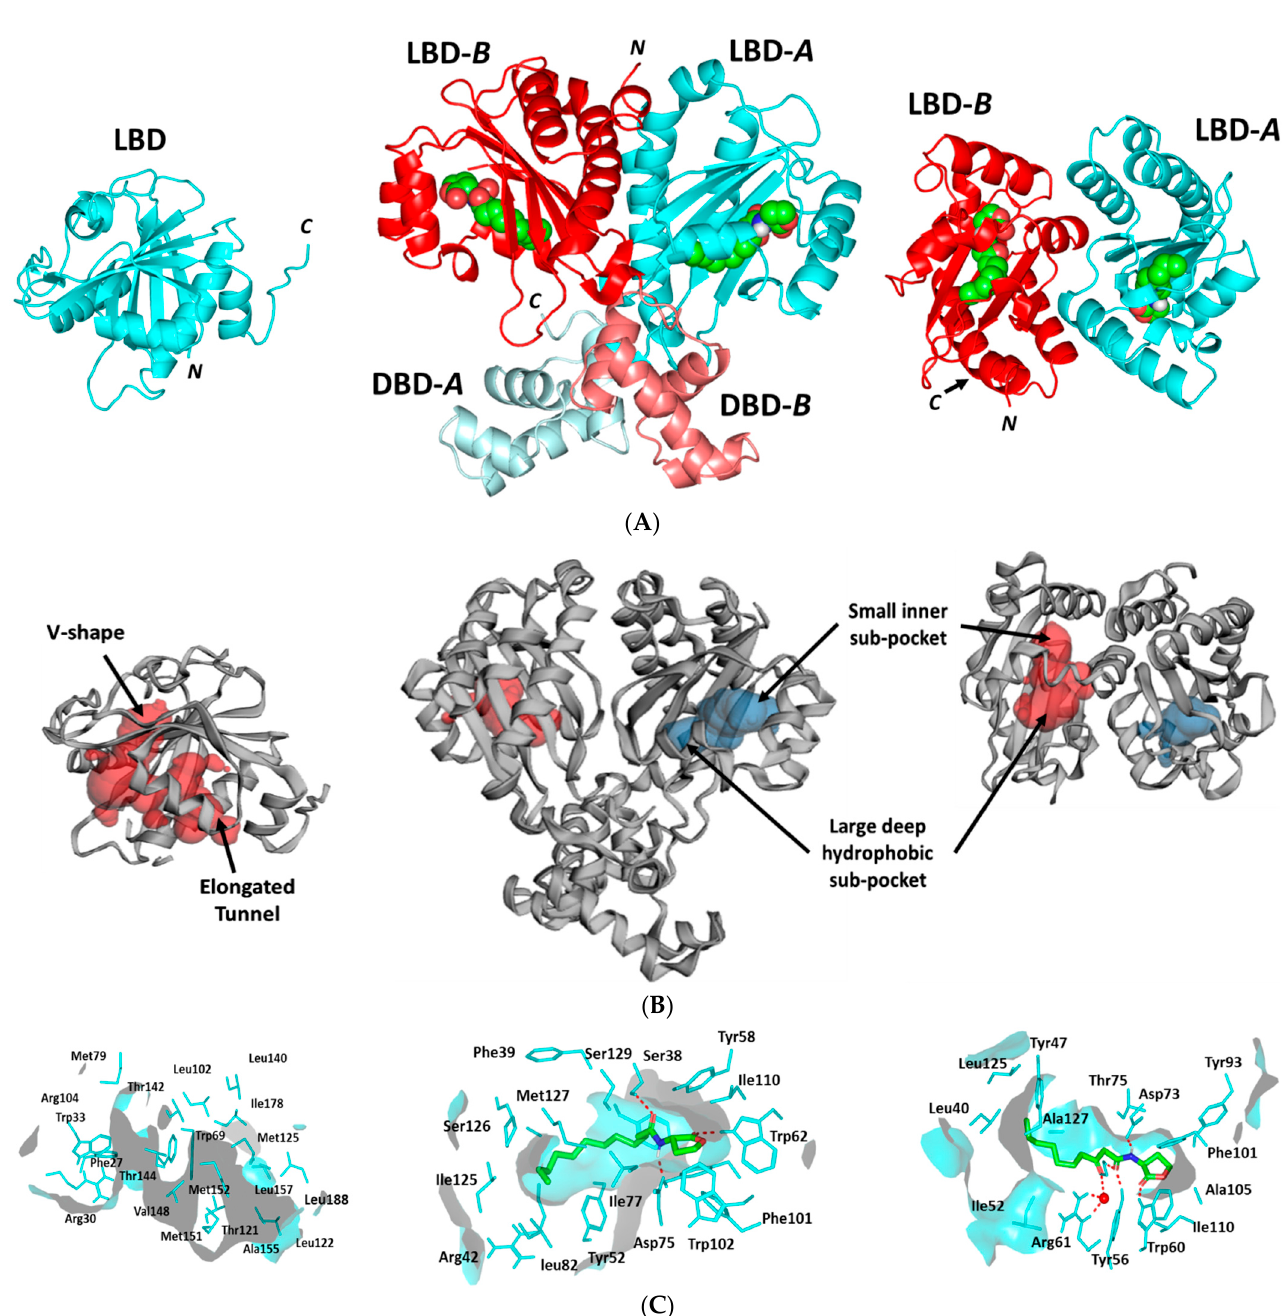
Figure 8. Two- and 3D-dimensional structural representation of linagliptin (LIN).